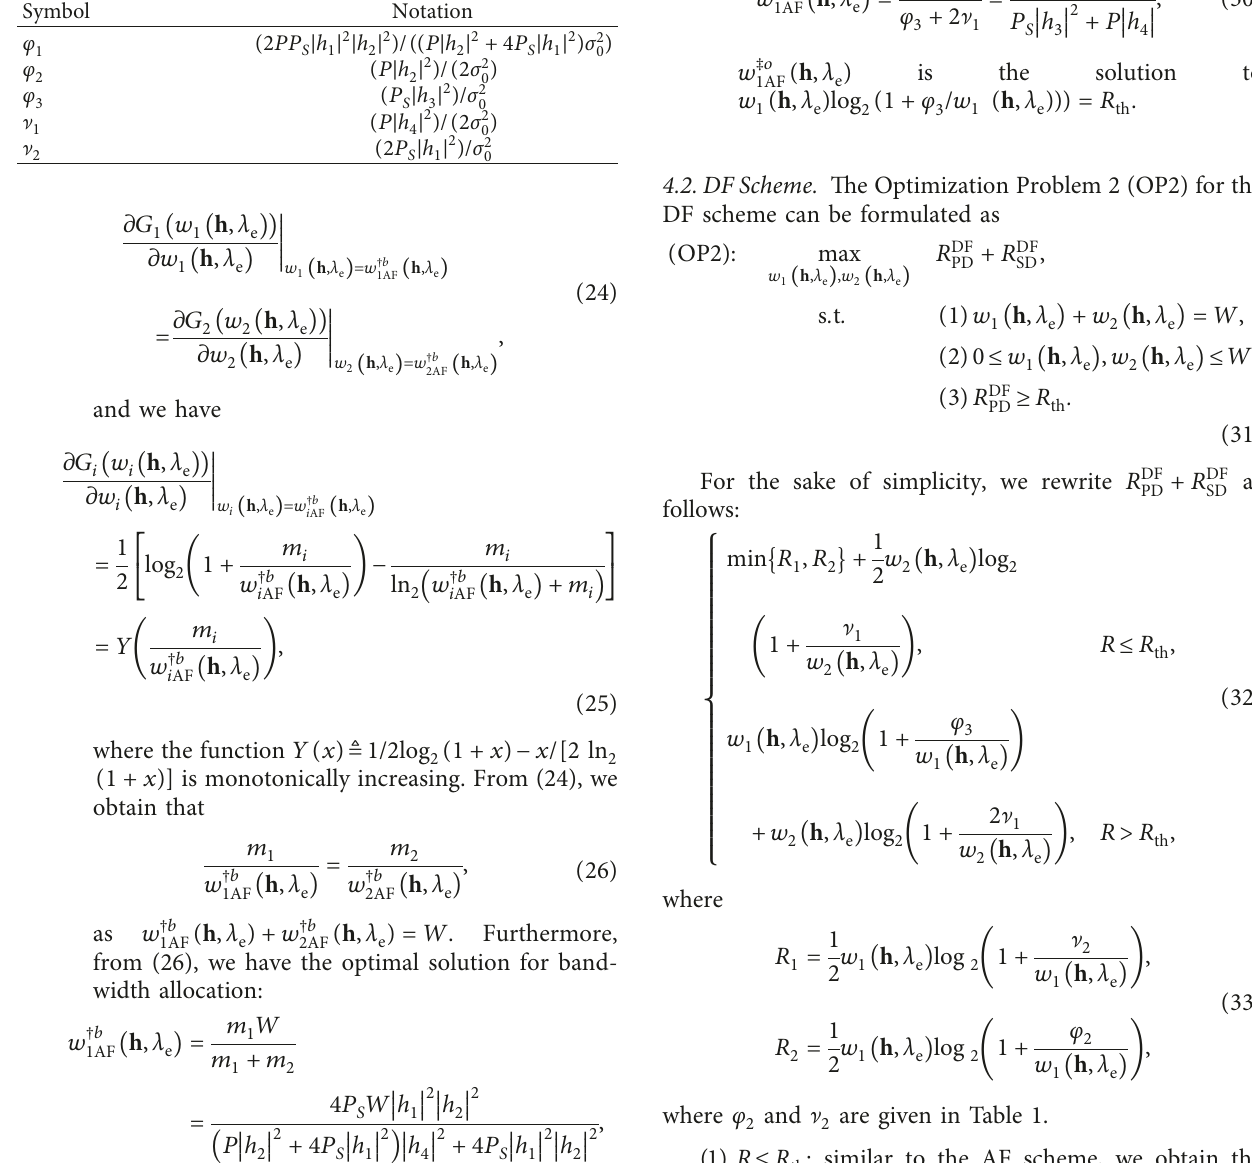
Table 1: Symbol notations. Symbol